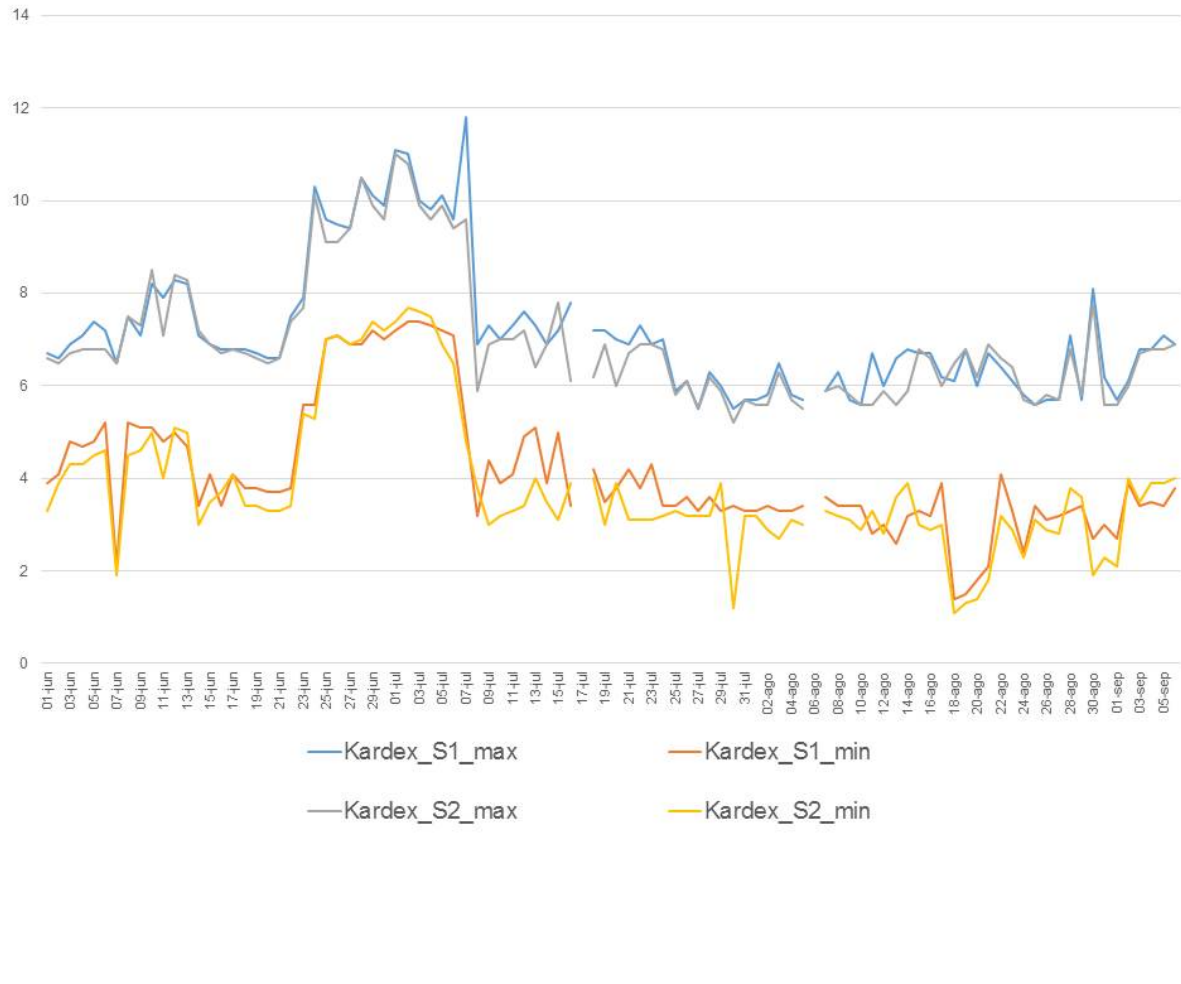
Figure 3. Maximum and minimum temperatures measured by the 2 probes in the refrigeration chamber from June 1, 2016 to September 6,